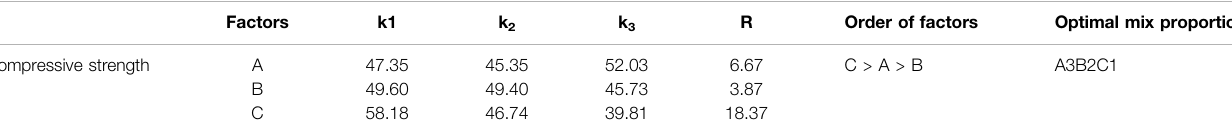
TABLE 11 | Range analysis for the compressive strength test of